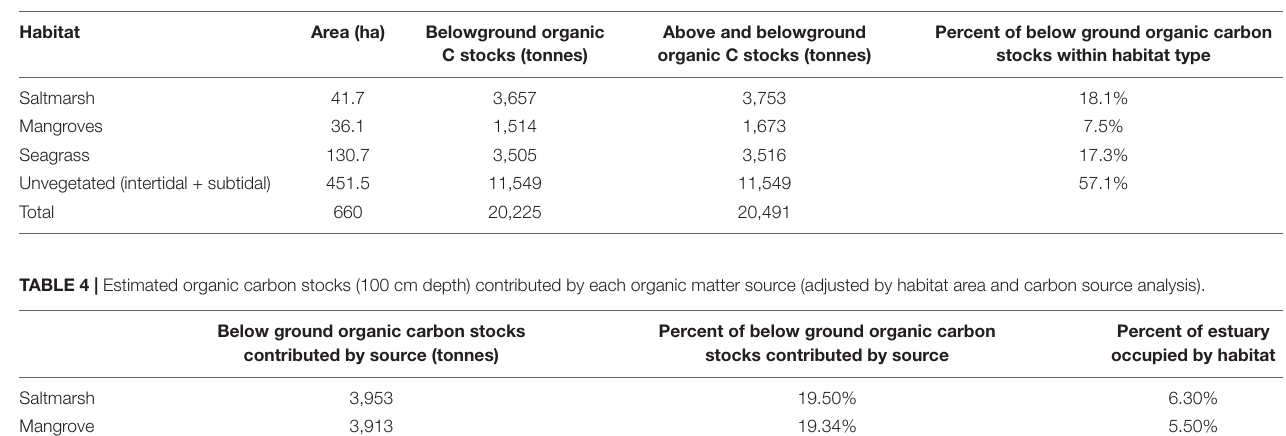
, δ 15 N ). Habitat group (sediment samples). 1, saltmarsh; 2, (cid:104) (cid:104)